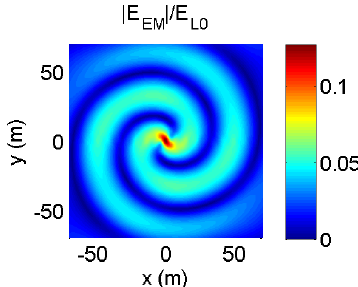
Figure 5. The amplitude of the electromagnetic waves at t = 5ms for a deep striation with relative depth α = 0 . 1, showing Z -mode waves propagating away from the striation. The wavelength of the Z mode is λ ≈ 59 . 23m at frequency ω 0 = 21 . 127 × 10 6 s − 1